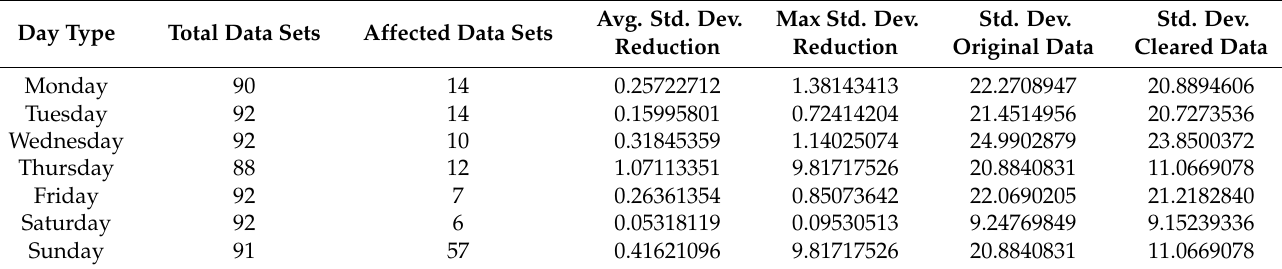
Table 7. Summer baseline for original and cleared data.